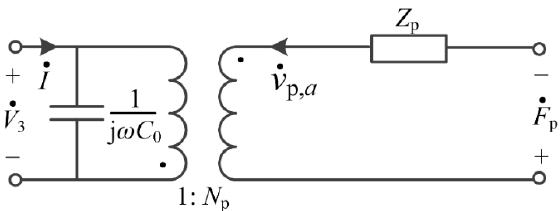
Figure 3. The equivalent circuit of the PZT (Pb(Zr,Ti)O 3 ) layer.